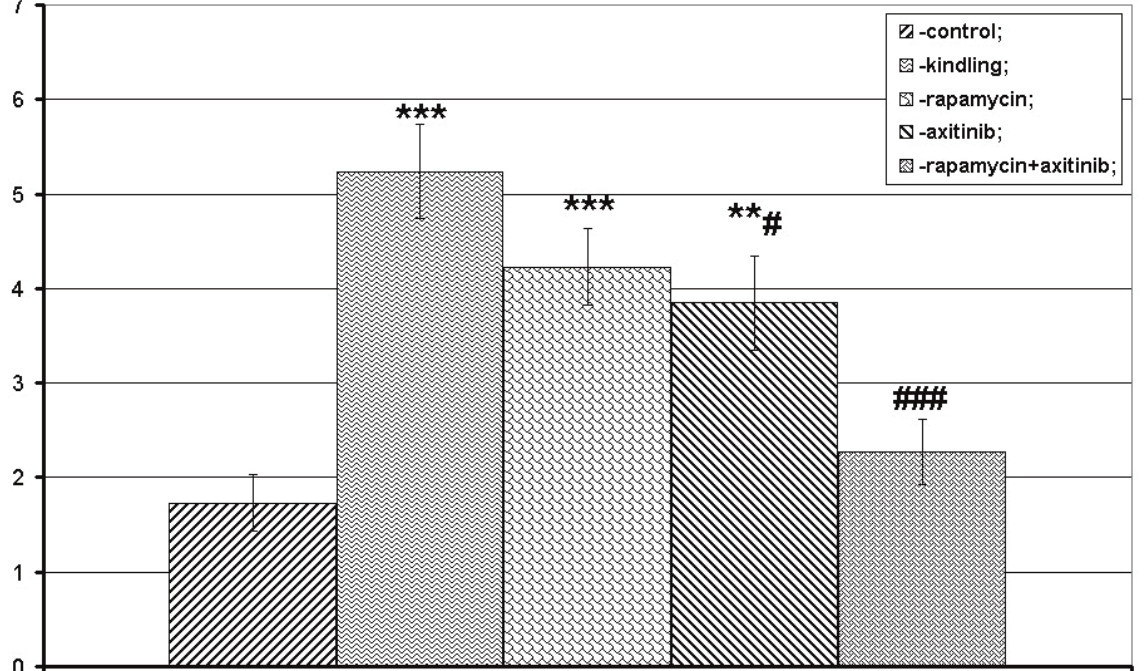
Fig. 7. Effects of treatment with rapamycin and axitinib upon NF-kB expression in the hippocampus of